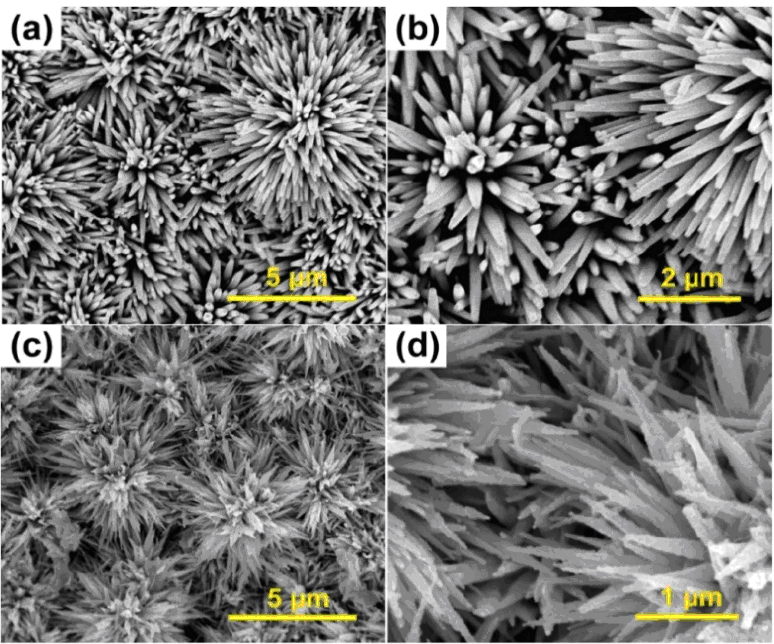
Figure 2. SEM images of WO 3 @ZIF-71 and WO 3 nano-rods; ( a , b ) WO 3 nano-rods at various magnifications; ( c , d ) WO 3 @ZIF-71 nano rods at various magnifications [87].